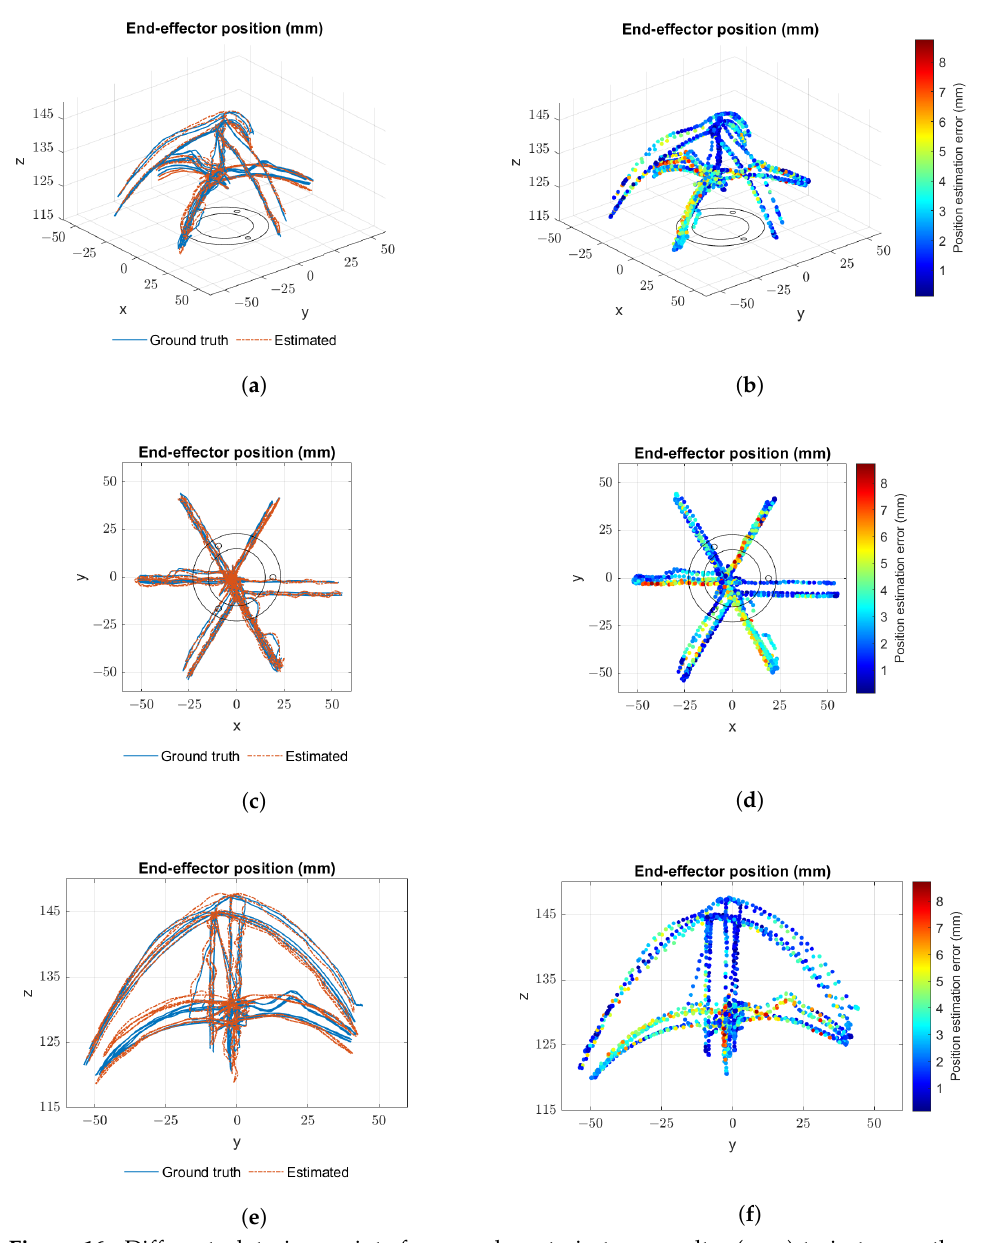
Figure 16. Different plot view points for open-loop trajectory results: ( a , c , e ) trajectory paths as perceived by the proprioceptive system (orange) and by the Polaris system (blue); ( b , d , f ) colour scale plot of the error between proprioceptive system readings and the